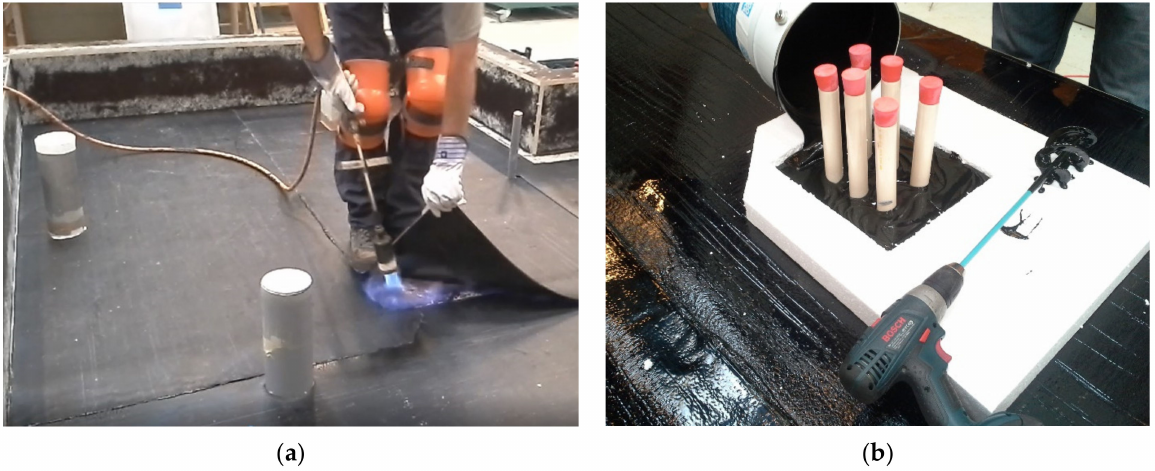
Figure 6. Mounting the test material inside the mock-up for System B, which is a firm bitumen-based radon blocker ( a ) combined with a two-component floating sealant ( b